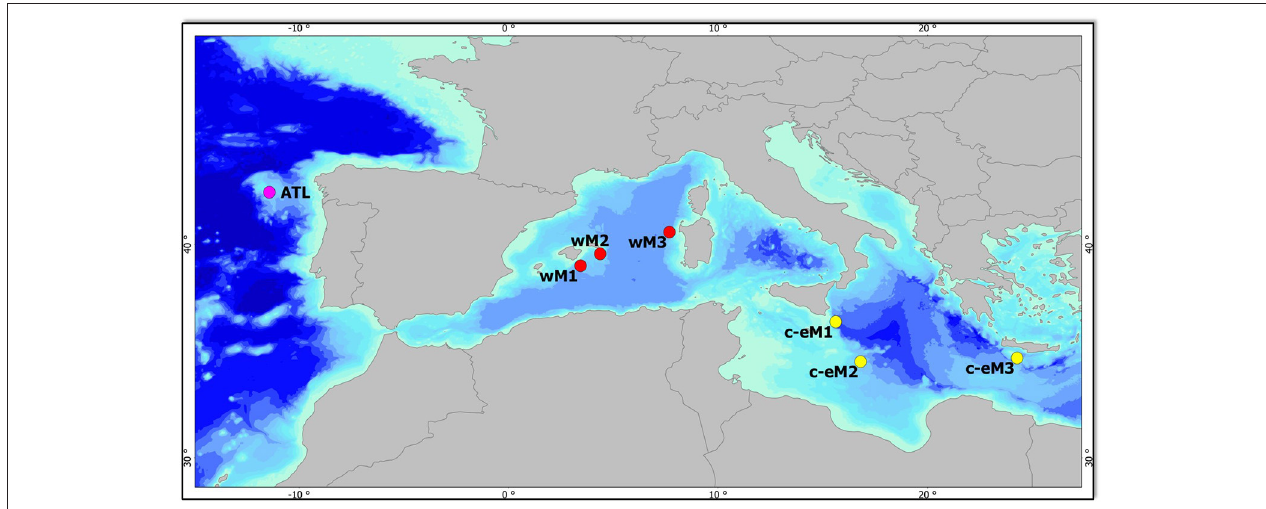
FIGURE 1 | Map of the study area and sampling sites. Purple circle, Galicia Bank—Atlantic Ocean (ATL); red circles, Western Mediterranean basin (wM1, 2, 3), yellow circles, Central-Eastern Mediterranean basin (c-eM1, 2, 3).